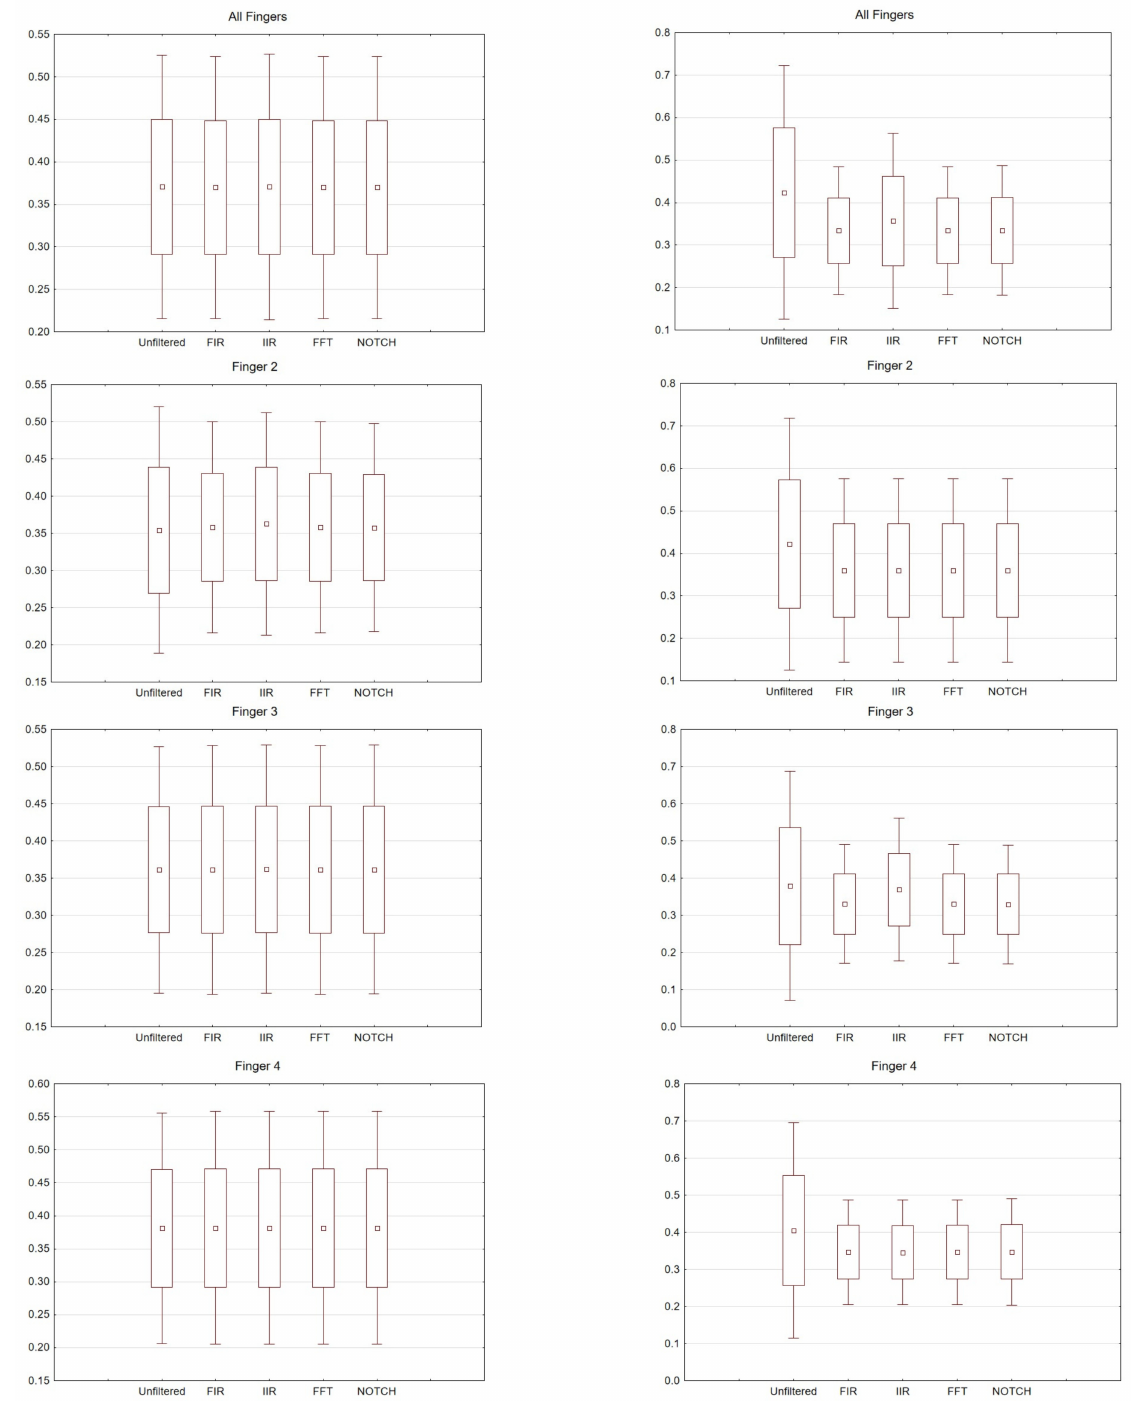
Figure 7. Box and whisker plot depicting amplitude values for averaged values, fingers 2, 3 and 4. From the left: Right hand and left